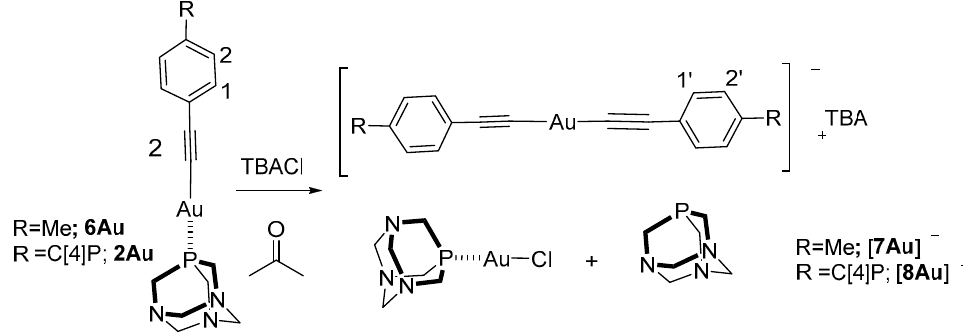
Scheme 2. Synthetic scheme for the formation of the anionic-bis(alkynyl)gold(I) complexes [ 7Au ] − and [ 8Au ] − with the corresponding proton assignment.